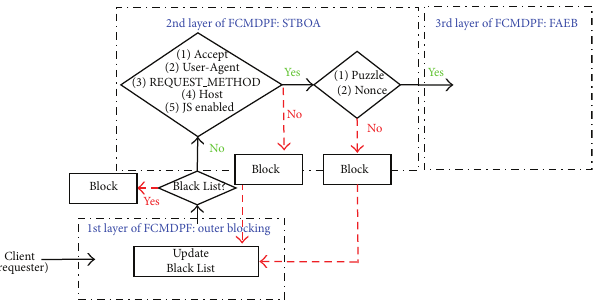
Figure 2: STBOA scheme processes and validates the incoming